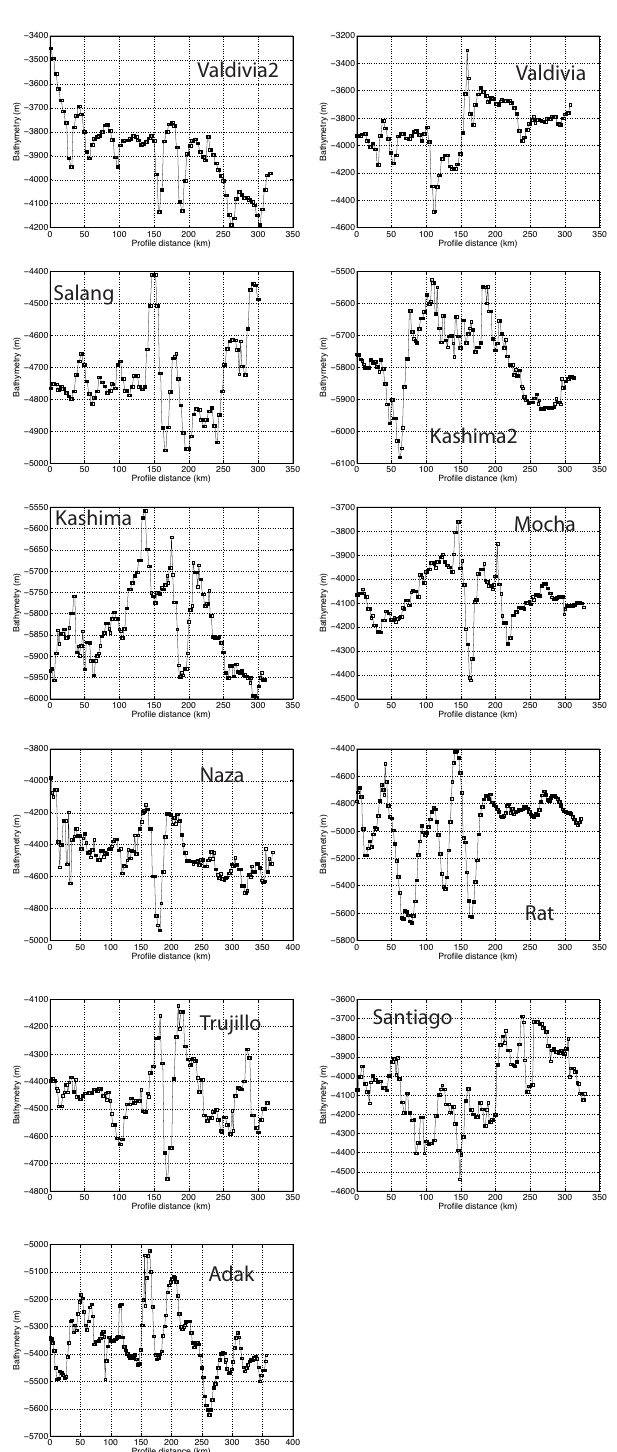
Fig. 8. Bathymetric profiles across the 11-identified fracture zones associated with the 13 largest of the top 15 earthquakes in the cou- pling